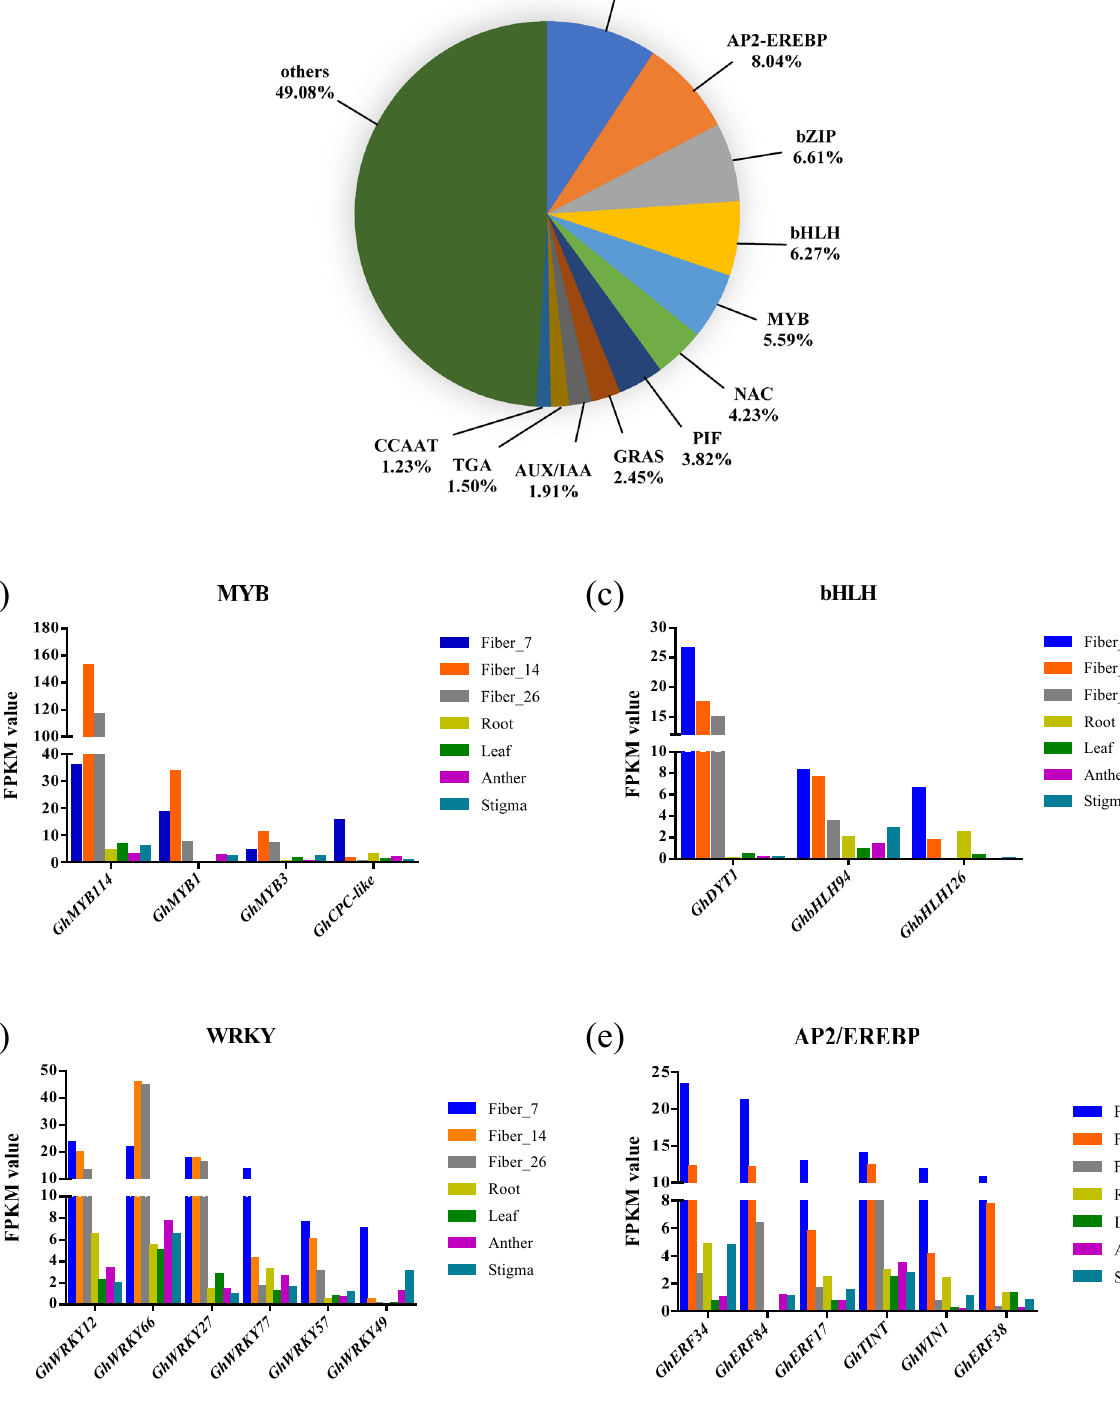
Figure 8. Statistics of transcription factor expression in different tissues of cotton. ( a ) Quantity and classification of transcription factor families. A total of 1467 different transcription factors were annotated in 46 transcription factor families. The numbers represent the percentages of transcription factor genes. ( b – e ) Detailed illustration of the expression of transcription factors related to fiber elongation and development. The x-axis indicates the distribution of transcription factors in seven different tissues of cotton. The y-axis represents the FPKM value of each transcription factor in different